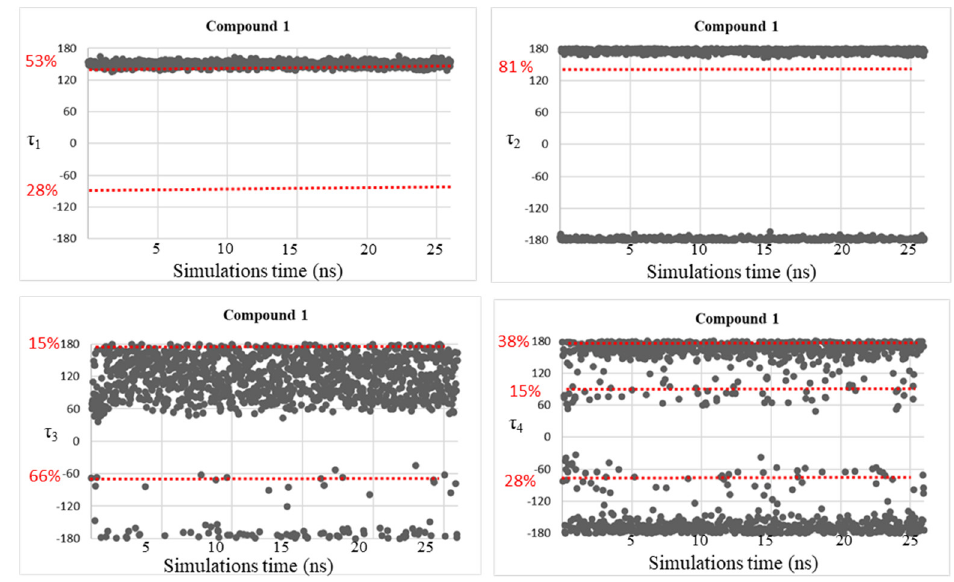
Figure 5. Dihedral torsion angle values τ 1 , τ 2 , τ 3 , and τ 4 of compound 1 over the MD simulations. The red dotted line highlights the torsional angles values, found by DFT calculations, in the most populated energy minima. The red label on the left displays the corresponding population percentage.